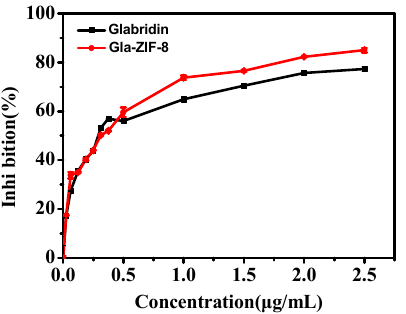
Figure 4. Tyrosinase inhibitory activities of free glabridin and Gla-ZIF-8.